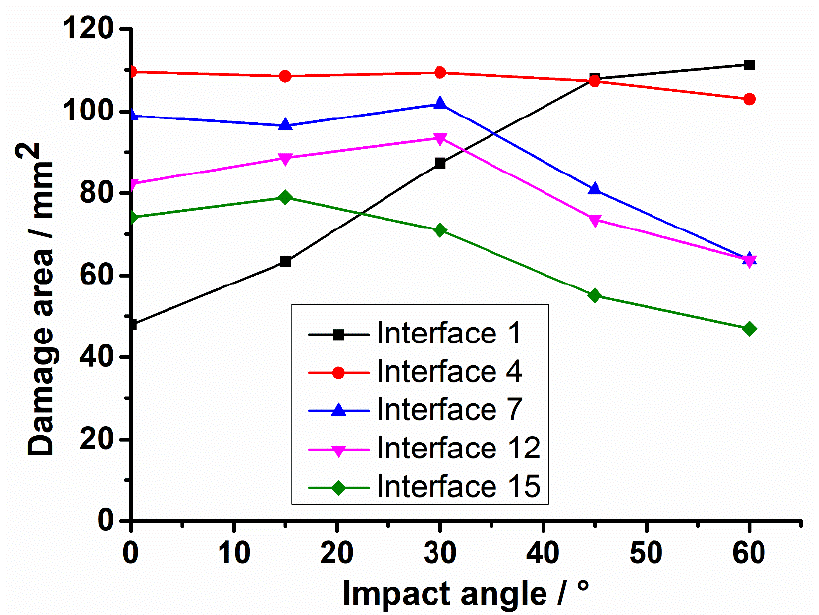
Figure 10. Variation tendency of damage area with impact angle under 20 J impact energy.